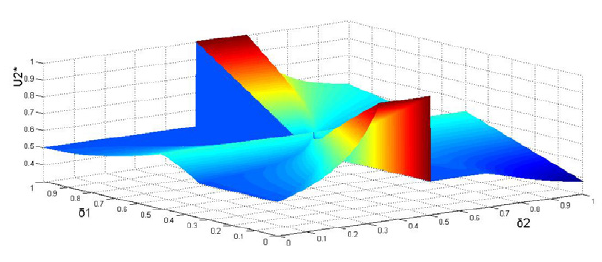
Figure 6. T he relationship